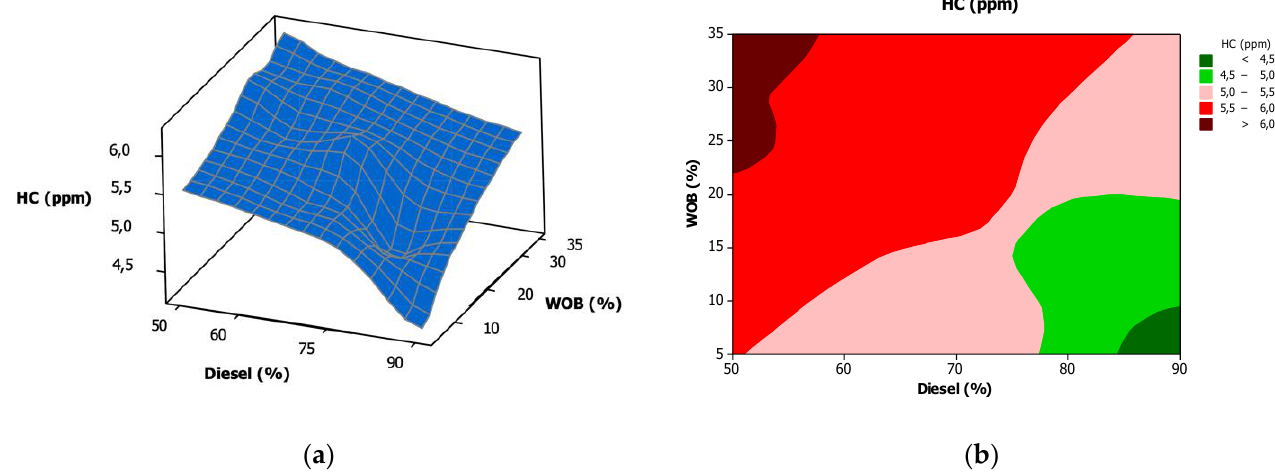
Figure 6. ( a ) Surface plot; ( b ) contour plot of HC emission with input variables.